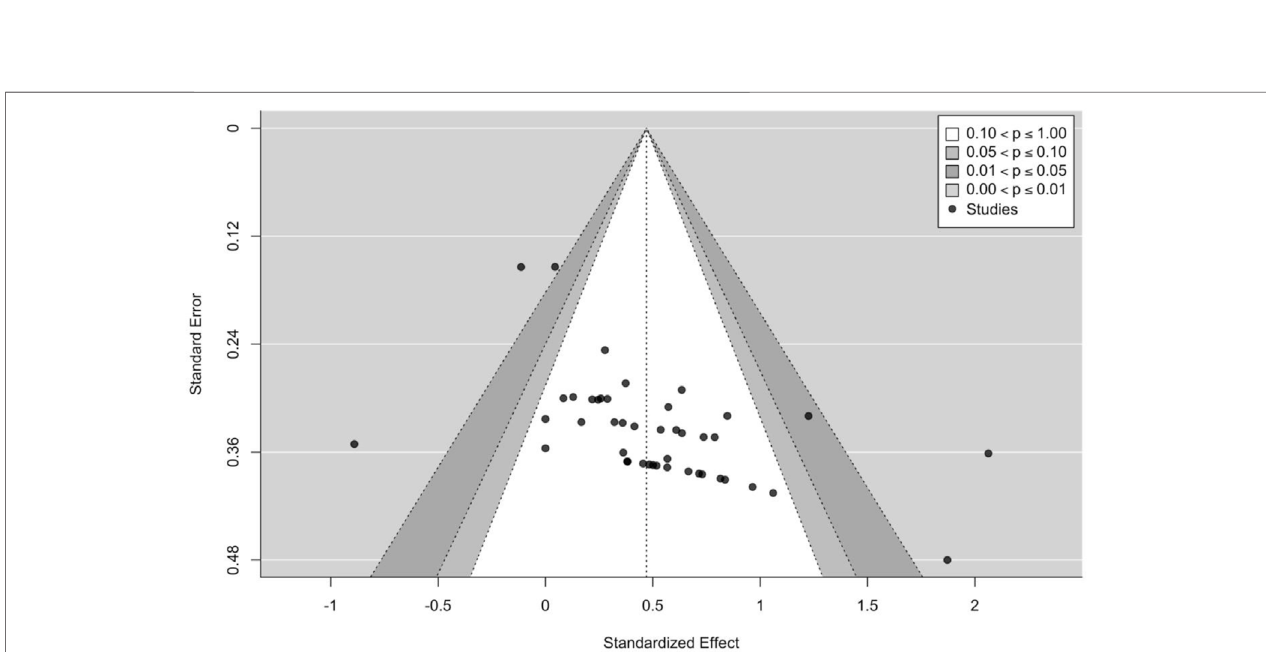
FIGURE 3 | Contour enhanced funnel plot for all